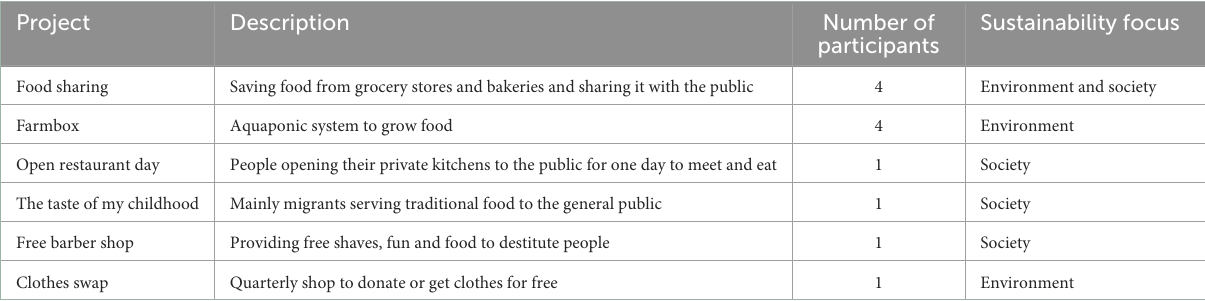
TABLE 1 Projects represented at the online workshop.